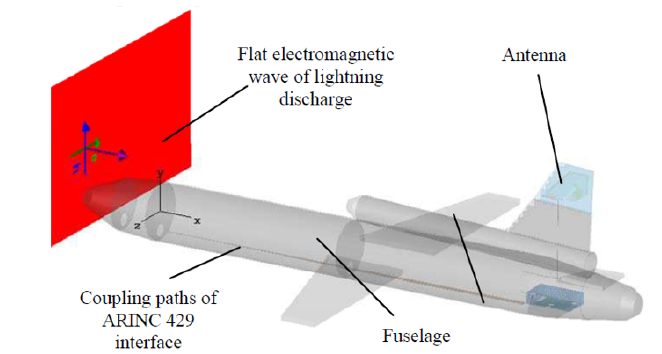
Figure 13. Example of a UAV model.